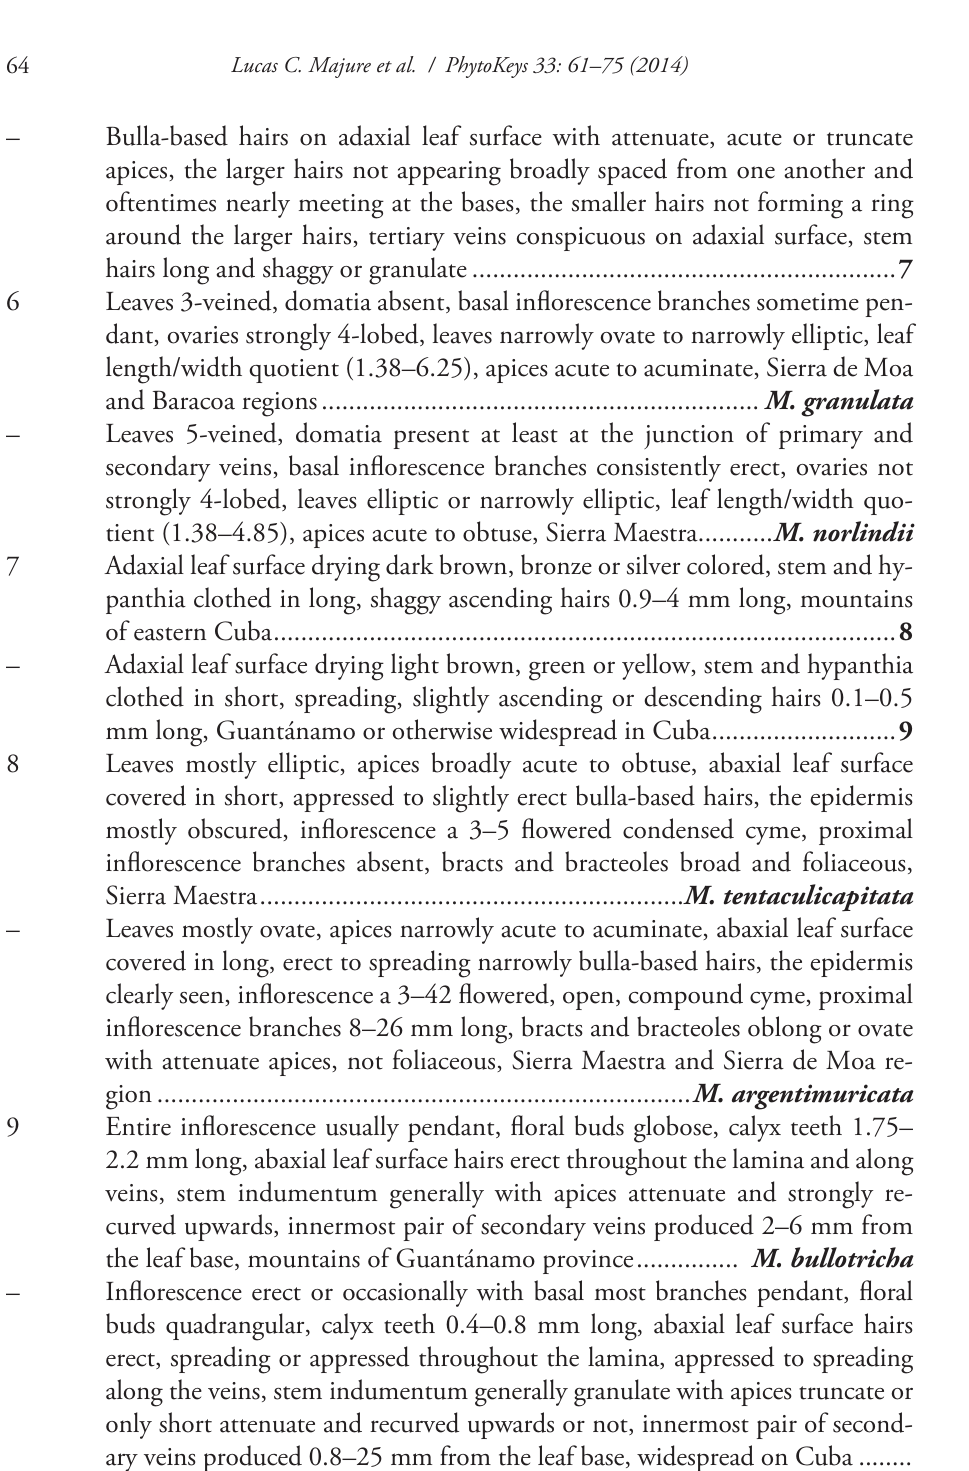
– Bulla-based hairs on adaxial leaf surface with attenuate, acute or truncate apices, the larger hairs not appearing broadly spaced from one another and oftentimes nearly meeting at the bases, the smaller hairs not forming a ring around the larger hairs, tertiary veins conspicuous on adaxial surface, stem hairs long and shaggy or granulate .............................................................. 7 6 Leaves 3-veined, domatia absent, basal inflorescence branches sometime pen- dant, ovaries strongly 4-lobed, leaves narrowly ovate to narrowly elliptic, leaf length/width quotient (1.38–6.25), apices acute to acuminate, Sierra de Moa and Baracoa regions ................................................................ M. granulata – Leaves 5-veined, domatia present at least at the junction of primary and secondary veins, basal inflorescence branches consistently erect, ovaries not strongly 4-lobed, leaves elliptic or narrowly elliptic, leaf length/width quo- tient (1.38–4.85), apices acute to obtuse, Sierra Maestra ........... M. norlindii 7 Adaxial leaf surface drying dark brown, bronze or silver colored, stem and hy- panthia clothed in long, shaggy ascending hairs 0.9–4 mm long, mountains of eastern Cuba ........................................................................................... 8 – Adaxial leaf surface drying light brown, green or yellow, stem and hypanthia clothed in short, spreading, slightly ascending or descending hairs 0.1–0.5 mm long, Guantánamo or otherwise widespread in Cuba ........................... 9 8 Leaves mostly elliptic, apices broadly acute to obtuse, abaxial leaf surface covered in short, appressed to slightly erect bulla-based hairs, the epidermis mostly obscured, inflorescence a 3–5 flowered condensed cyme, proximal inflorescence branches absent, bracts and bracteoles broad and foliaceous, Sierra Maestra .............................................................. M. tentaculicapitata – Leaves mostly ovate, apices narrowly acute to acuminate, abaxial leaf surface covered in long, erect to spreading narrowly bulla-based hairs, the epidermis clearly seen, inflorescence a 3–42 flowered, open, compound cyme, proximal inflorescence branches 8–26 mm long, bracts and bracteoles oblong or ovate with attenuate apices, not foliaceous, Sierra Maestra and Sierra de Moa re- gion .............................................................................. M. argentimuricata 9 Entire inflorescence usually pendant, floral buds globose, calyx teeth 1.75– 2.2 mm long, abaxial leaf surface hairs erect throughout the lamina and along veins, stem indumentum generally with apices attenuate and strongly re- curved upwards, innermost pair of secondary veins produced 2–6 mm from the leaf base, mountains of Guantánamo province ............... M. bullotricha – Inflorescence erect or occasionally with basal most branches pendant, floral buds quadrangular, calyx teeth 0.4–0.8 mm long, abaxial leaf surface hairs erect, spreading or appressed throughout the lamina, appressed to spreading along the veins, stem indumentum generally granulate with apices truncate or only short attenuate and recurved upwards or not, innermost pair of second- ary veins produced 0.8–25 mm from the leaf base, widespread on Cuba